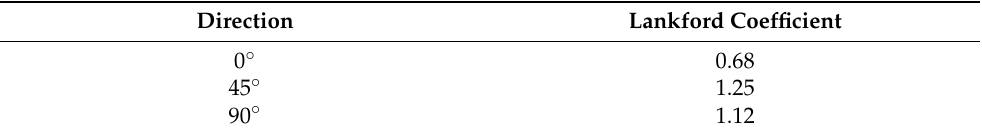
Table 5. Lankford coefficient for the test material.